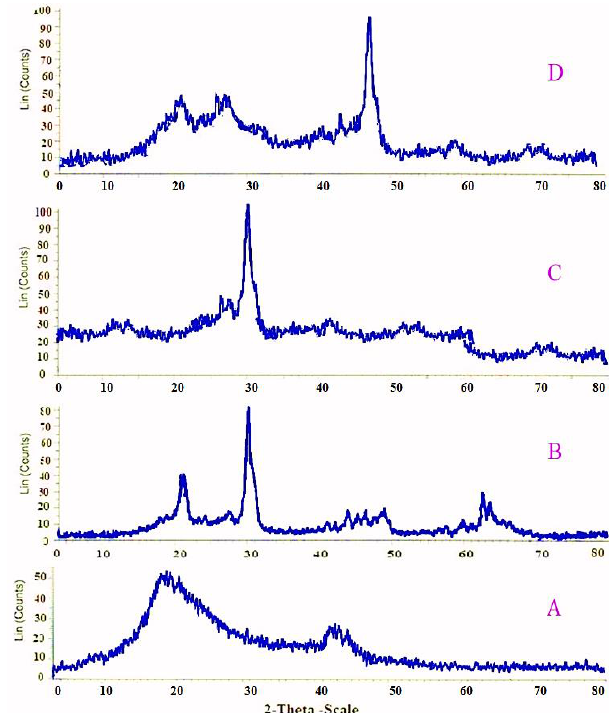
Figure 6. XRD analysis of ( A ) native, ( B ) lead-loaded, ( C ) cadmium-loaded, ( D ) nickel-loaded S. cerevisiae